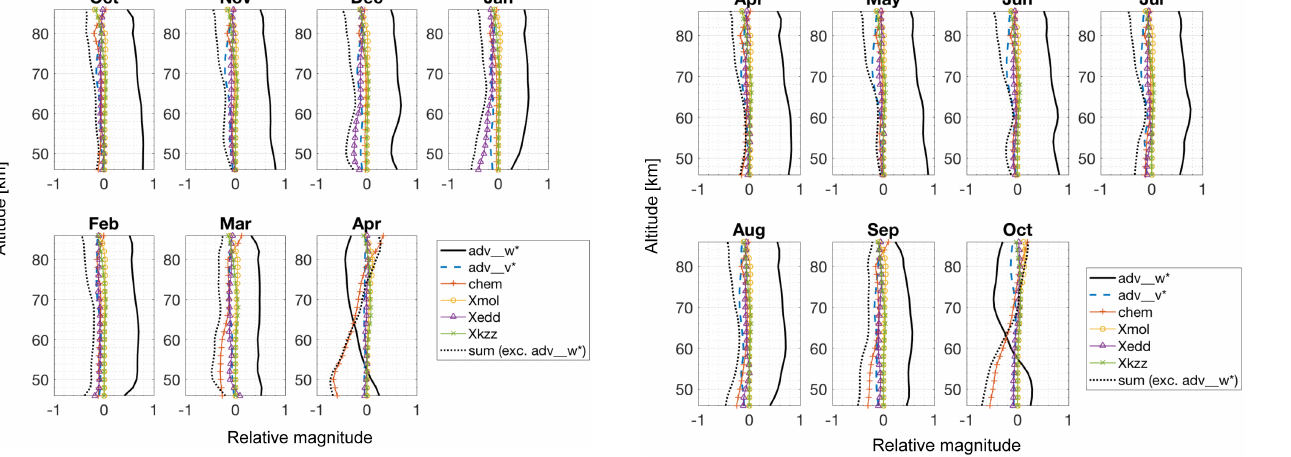
Figure 10. Same plots as for Fig. 9, but for the south polar aver- age (60–90 ◦ S), around the time of southern hemisphere winter, and with no exclusion of model output for SSWs.